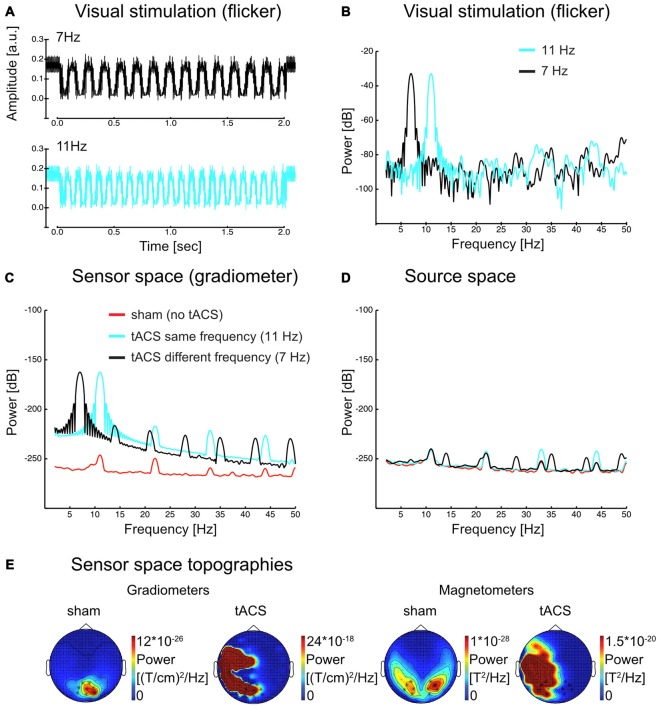
(A) Visual flicker as recorded with a photo diode (average over 50 trials in each flicker frequency) and (B) power spectrum of the same signal for each flicker frequency. (C) Sensor space (gradiometer) MEG data power spectrum in sham and tACS conditions for 11 Hz steady-state response (SSR). Harmonic activity is visible, yet considerably reduced compared to the fundamental. (D) Source space data of the same conditions as in (C) in visual cortex regions (see Figure 4 for the region of interest). The scale in (B–D) is dB (10*log10(power)). (E) Sensor space topographies. SSR topographies show occipital activity at the flicker frequency (11 Hz) in the sham condition. During tACS, the artifact is dominating the signal. Note [that] the left lateralized activity is a result of the tACS cables, which were placed on the left side of the participant’s head. Scales change drastically from sham to tACS (factor of around 107–108).